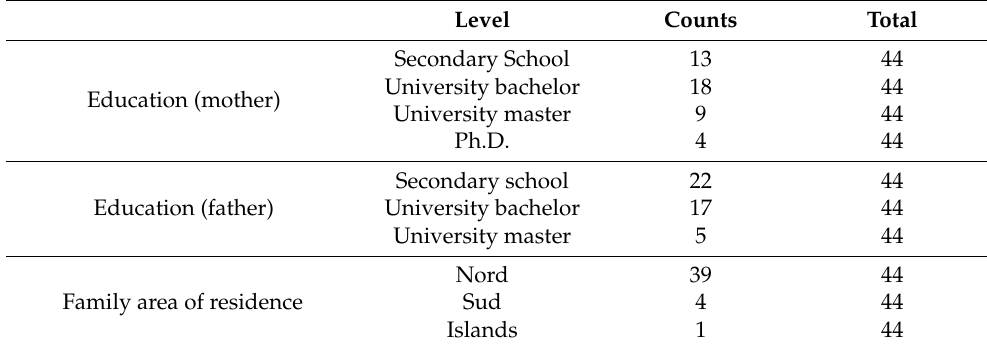
Table 1. Parents’ educational qualification and family residency.